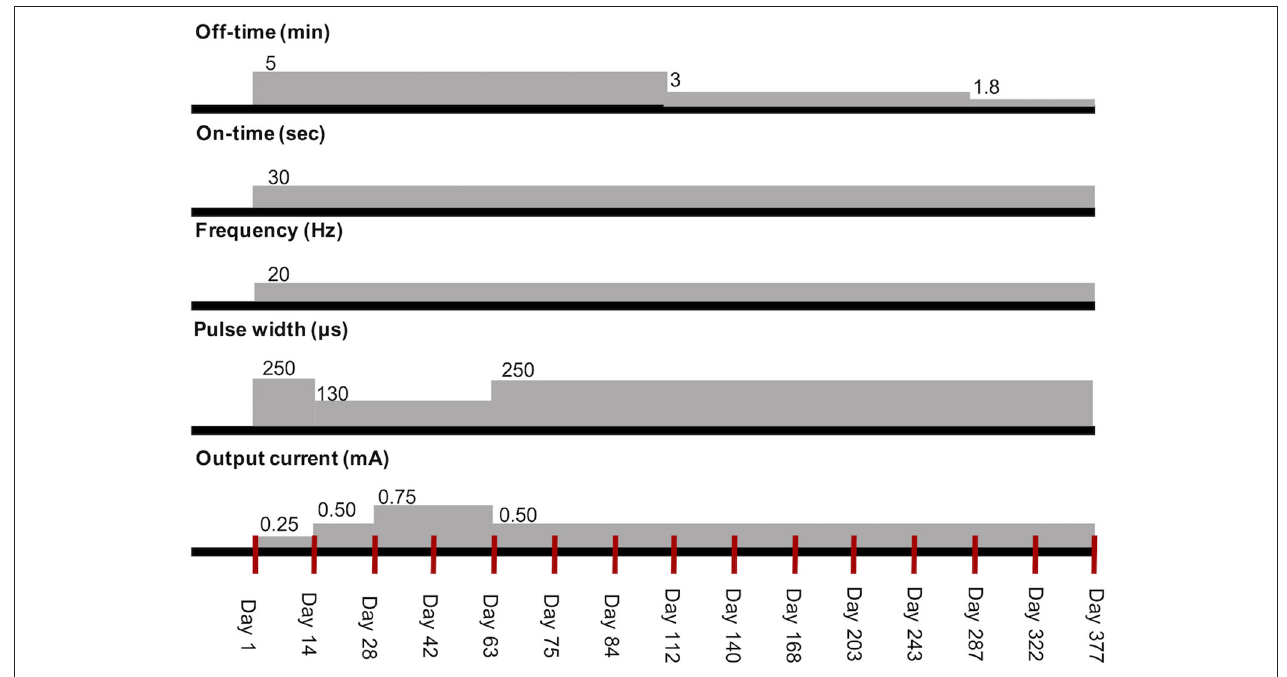
FIGURE 2 | Transition of stimulation parameters of VNS therapy in the dog. The red vertical lines mean each visit. VNS, vagus nerve stimulation.